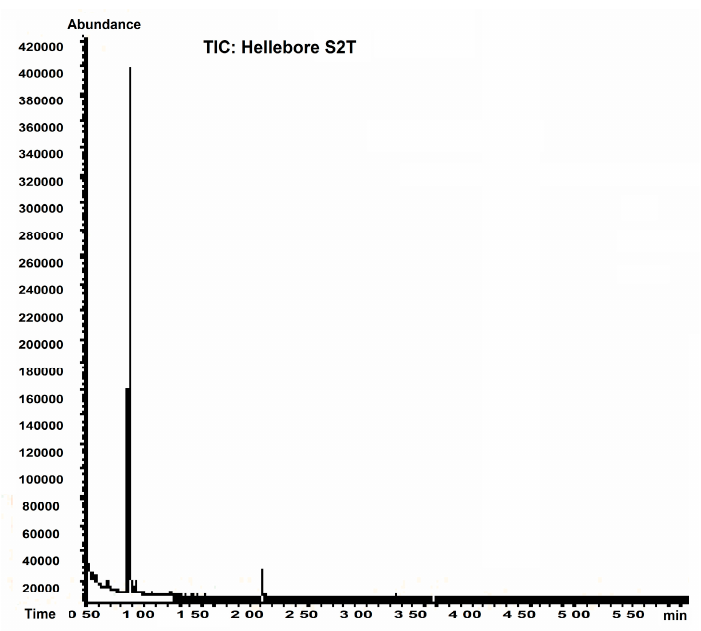
Figure 2. GC-MS chromatogram for S 1T and S 2T hellebore extract.